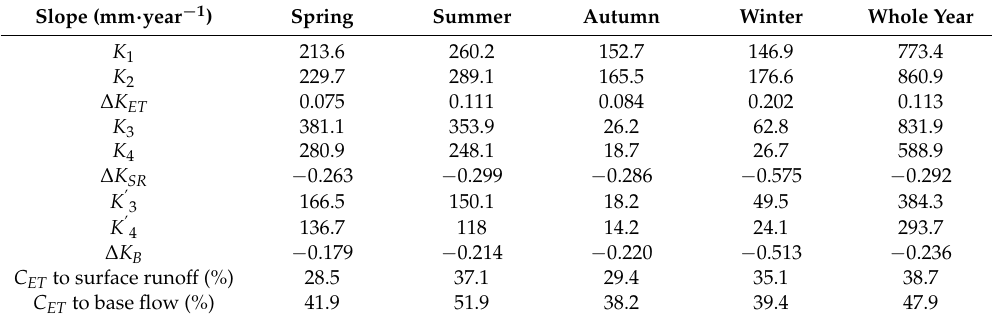
( K 3 , 4 ), base flow ( K ’ 3 , 4 ) and contribution rates of ET to surface runoff and base flow decrease.